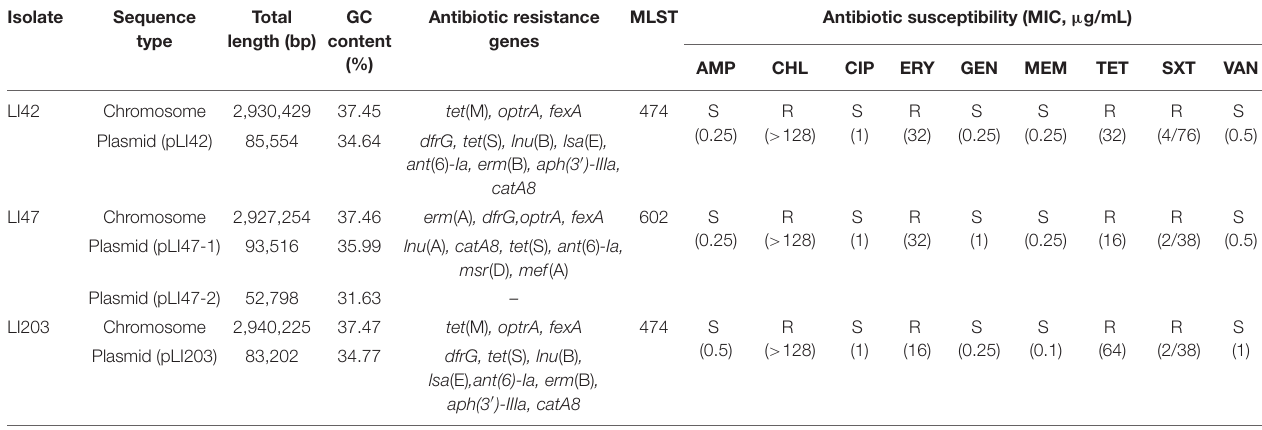
TABLE 1 | Summary for complete genome sequencing and antimicrobial resistance pheno- and genotypes of three L. innocua isolates.